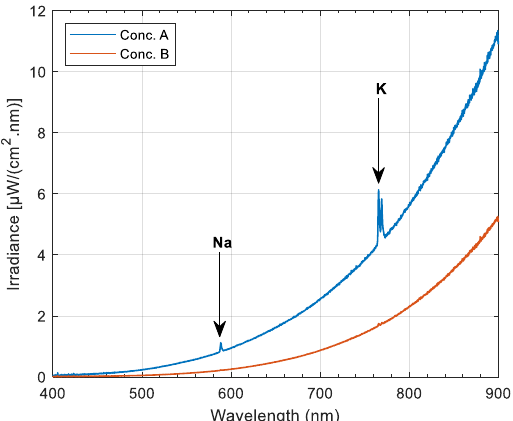
Figure 5. Average emission spectrum from the combustion of copper concentrates.